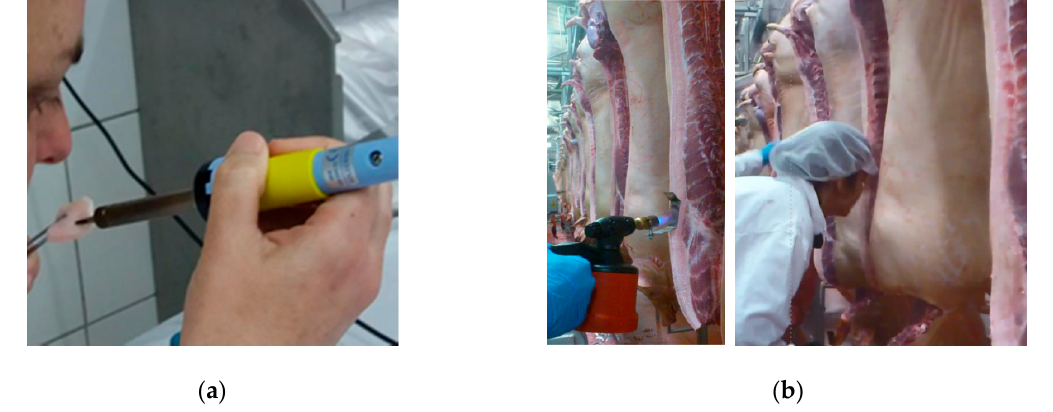
Figure 1. Human nose performed ( a ) at line and, ( b ) on line at a slaughter plant.